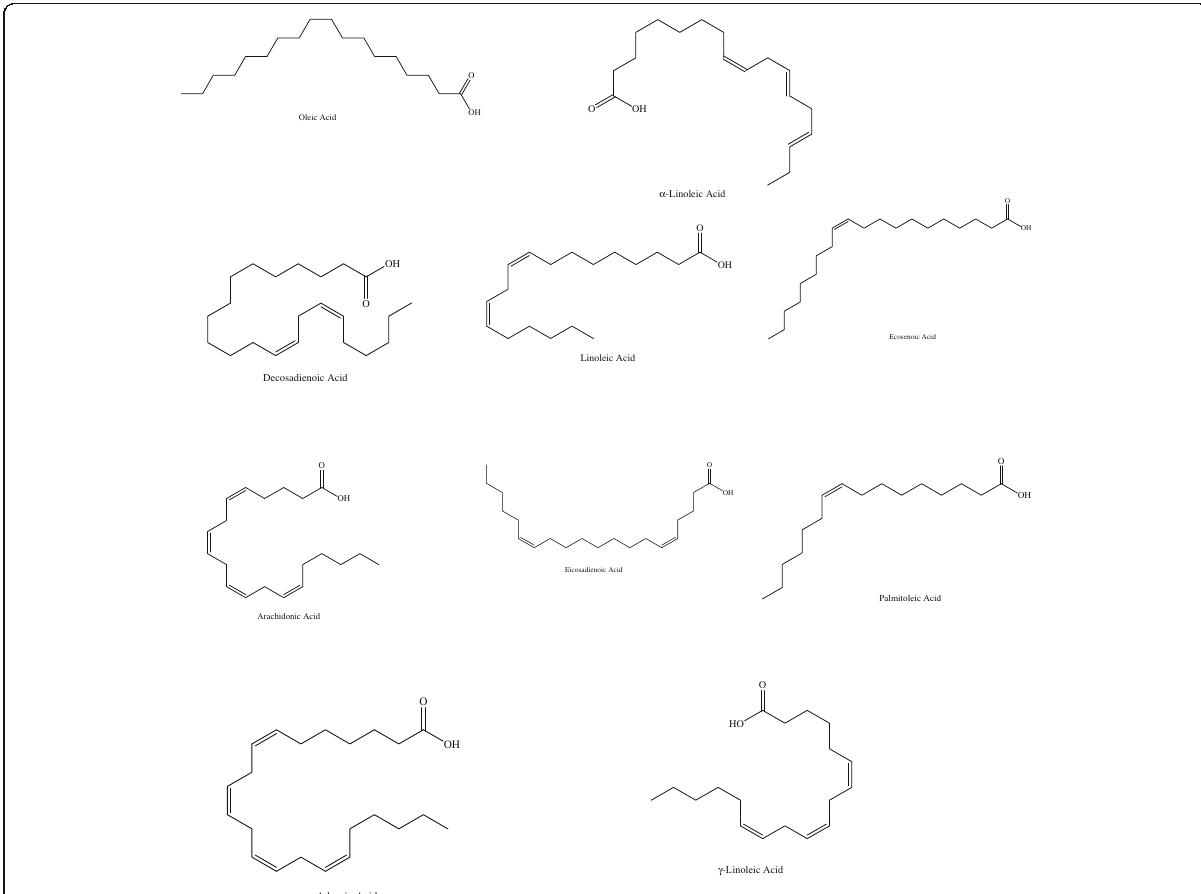
Fig. 4 Structure of the unsaturated fatty acid identified from GC-MS analysis of different parts of Cassia sophera